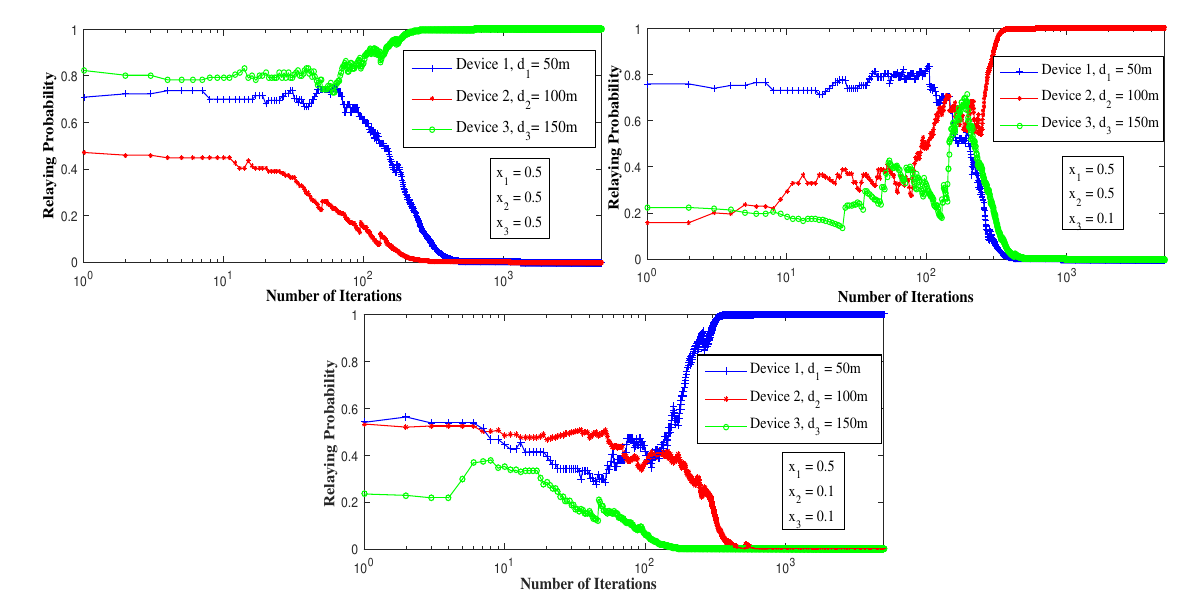
Figure 6. Convergence to pure Nash equilibrium using LRI, for different cooperation levels ( x i